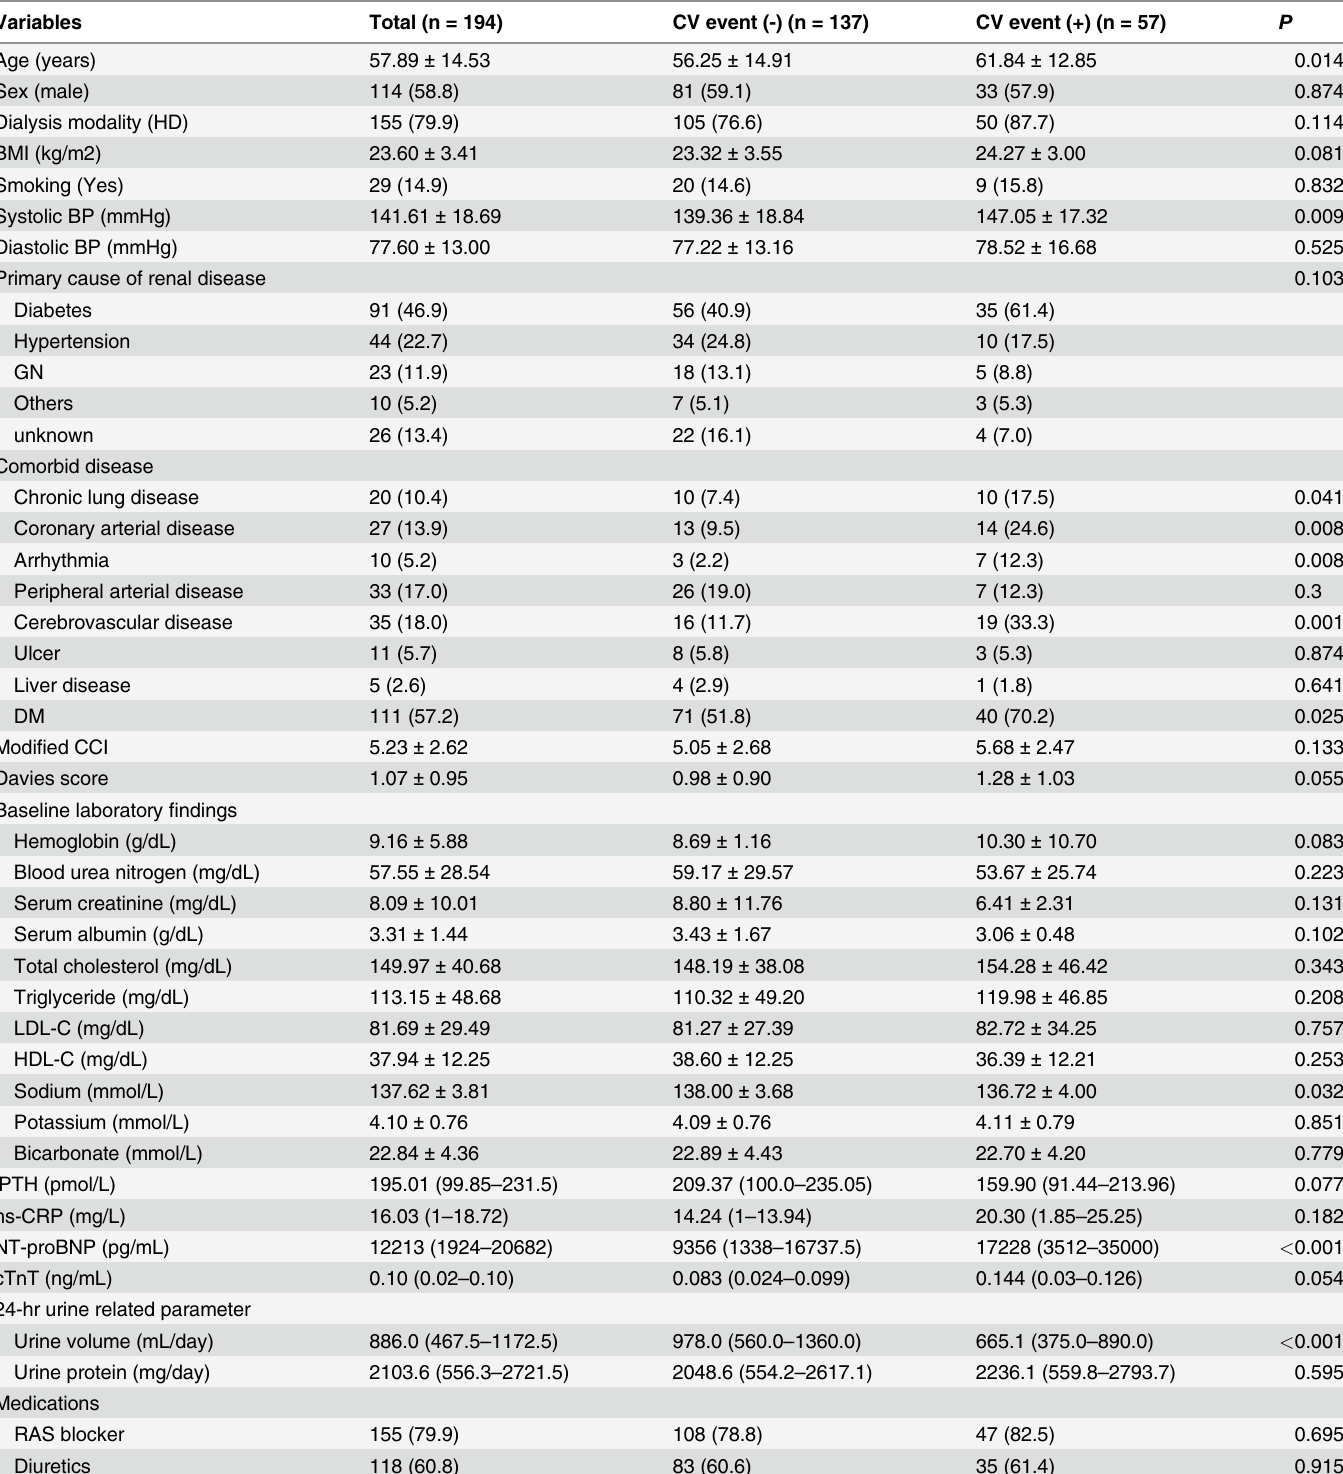
Table 2. Baseline characteristics of the study patients according to the presence of CV